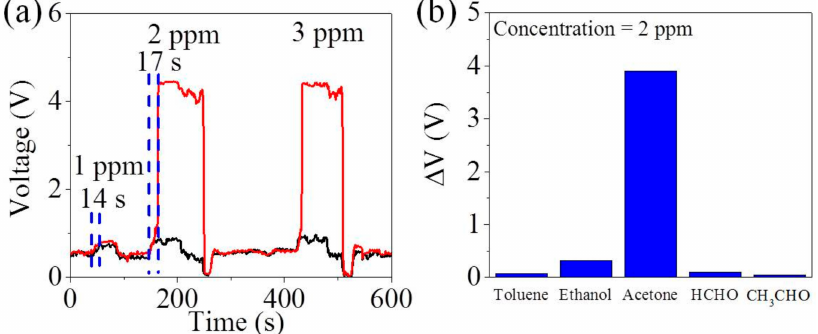
Figure 4. ( a ) Output voltage of MZO to acetone from 1 to 3 ppm in the traditional circuit and the interlocking p+n FET circuit (R L is 7.1 M Ω ) in the humid atmosphere of 85%; ( b ) The change of output voltage ( ∆ V) to different gases at 2 ppm (RH = 85%) for MZO in the interlocking p+n FET circuit (R L is 7.1 M Ω